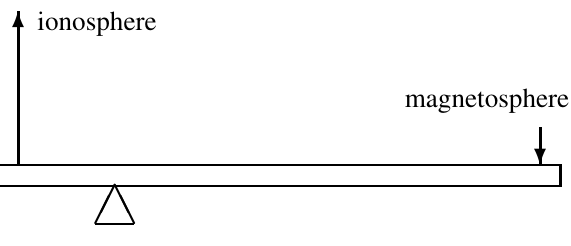
Fig. 2. Relation between forces in ionosphere and magnetosphere for system of region 1 currents (Fig. 1), illustrated by analogy to a simple lever system with mechanical advantage (antisunward is up).